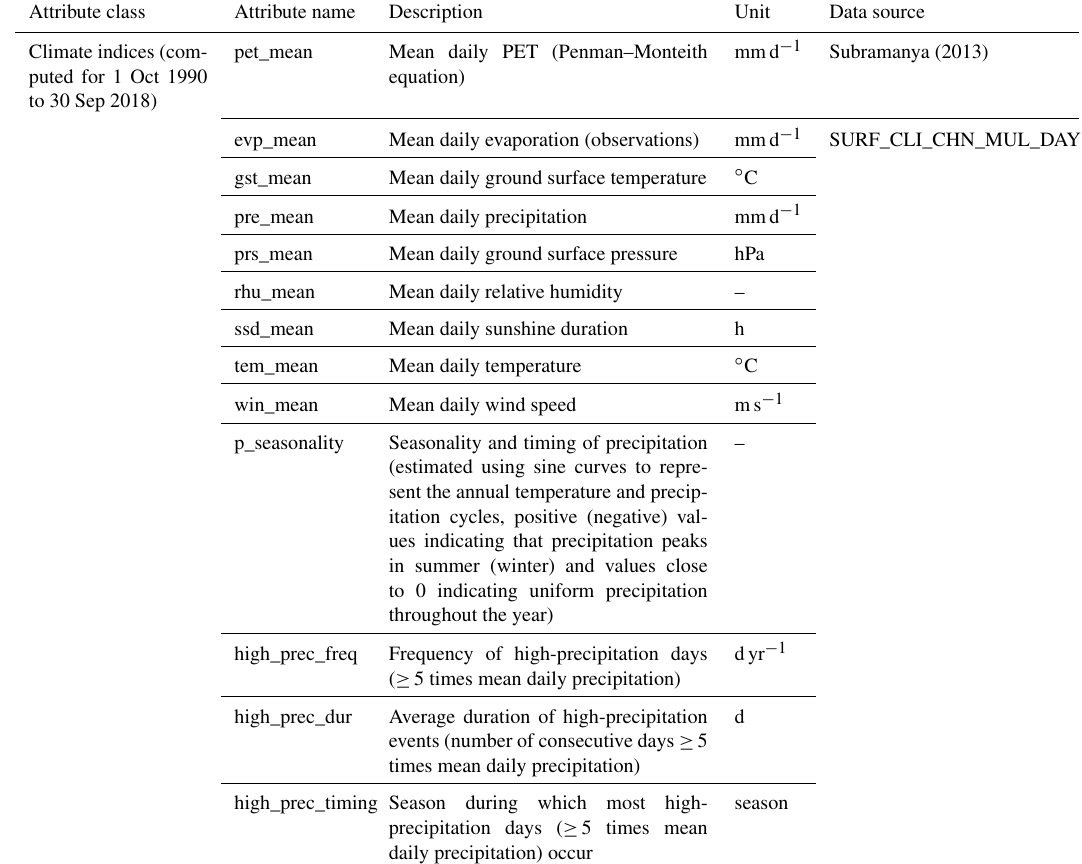
Table A1. Summary table of catchment attributes available in the proposed